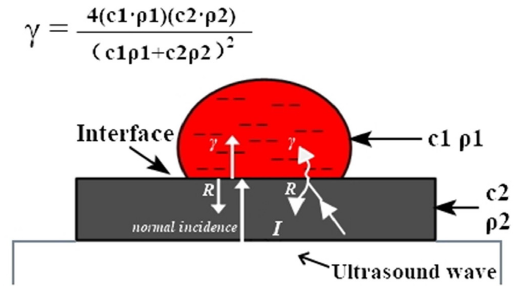
Figure 8. Schematic of the energy flow propagating in Al/SiC wetting